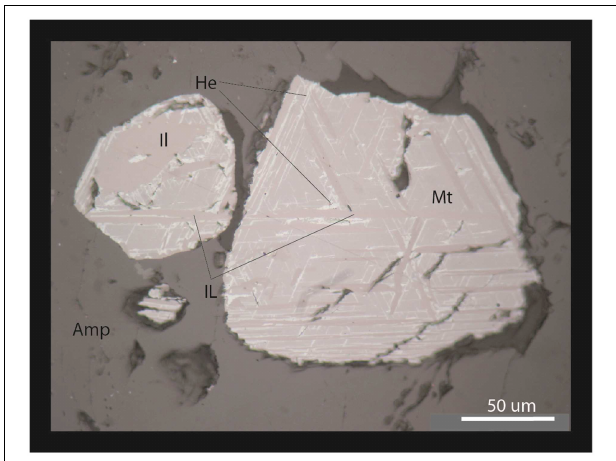
FIGURE 6 | Photomicrographs under reflected light microscopy of subhedral crystals of magnetite (Mt) with hematite (He) and ilmenite (Il) from the Neoproterozoic terrains of Socotra